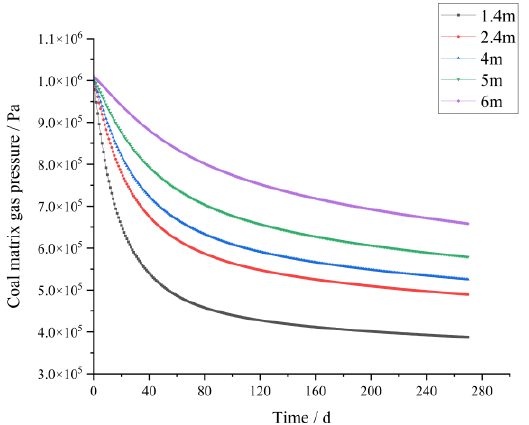
Figure 5. Variation in coal matrix gas pressure with time under different extraction spacing.